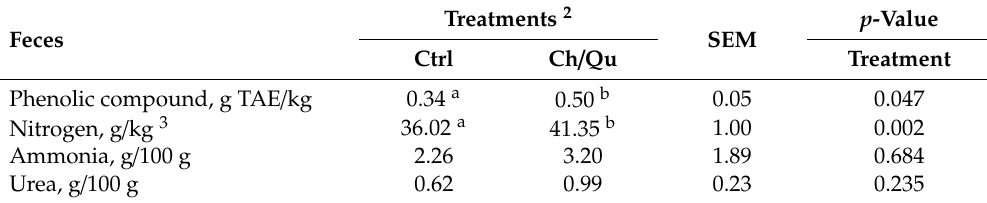
Table 5. Fecal metabolites of weaned piglets fed diets with tannins (Ch / Qu, n = 6) or without